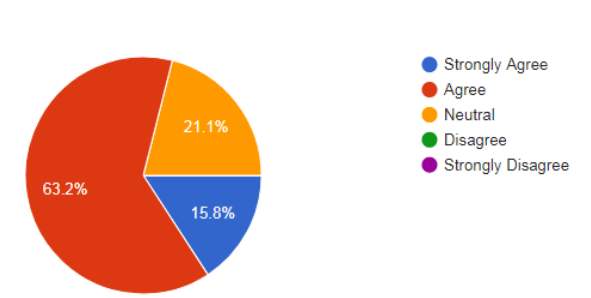
Figure 4: The content was organised and easy to